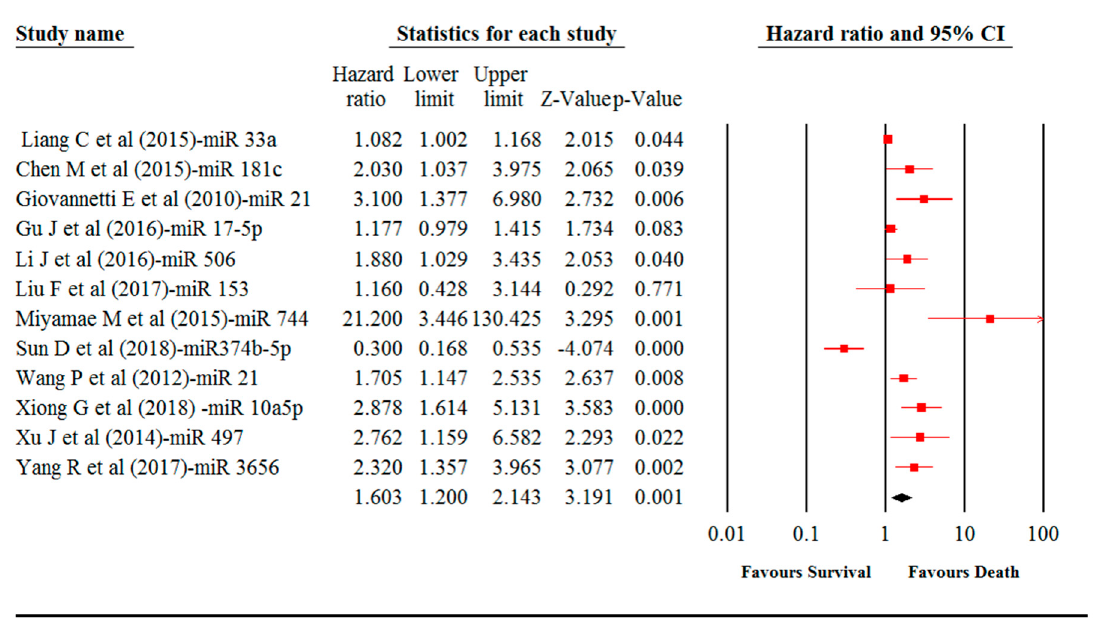
Figure 4. Forest plot for the HR and 95% CI of PC studies using meta-analysis. Random effect model; I squared = 83.833%; tau = 0.403; Q value = 68.042; df = 11. Cancers 2019 , 11 , x